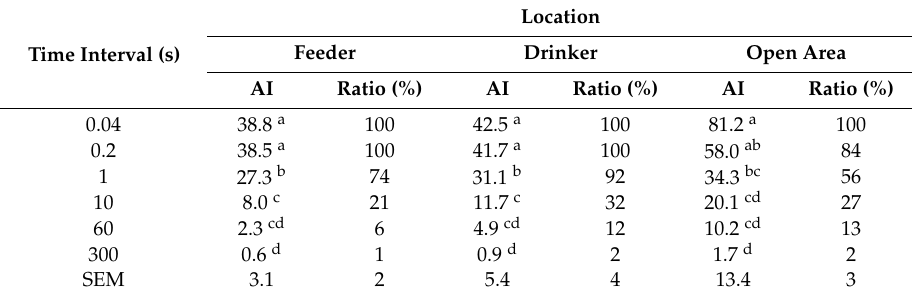
Table 1. Average broiler activity index (AI) with di ff erent time intervals at di ff erent locations.